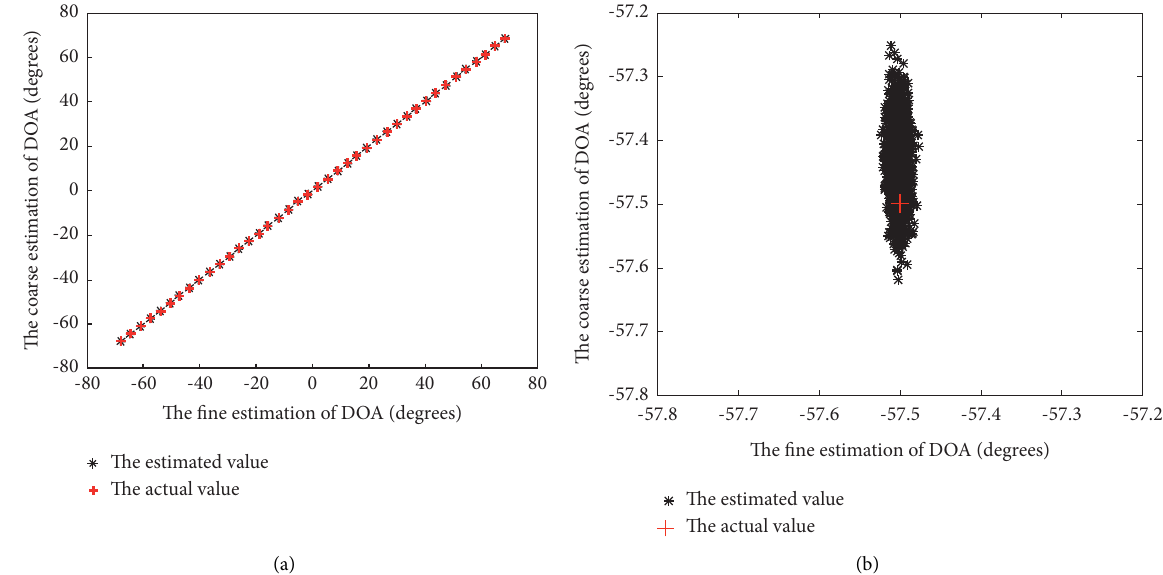
Figure 14: The simulation results of distributed super nested arrays. (a) DOA estimation. (b) Partial enlarged view.